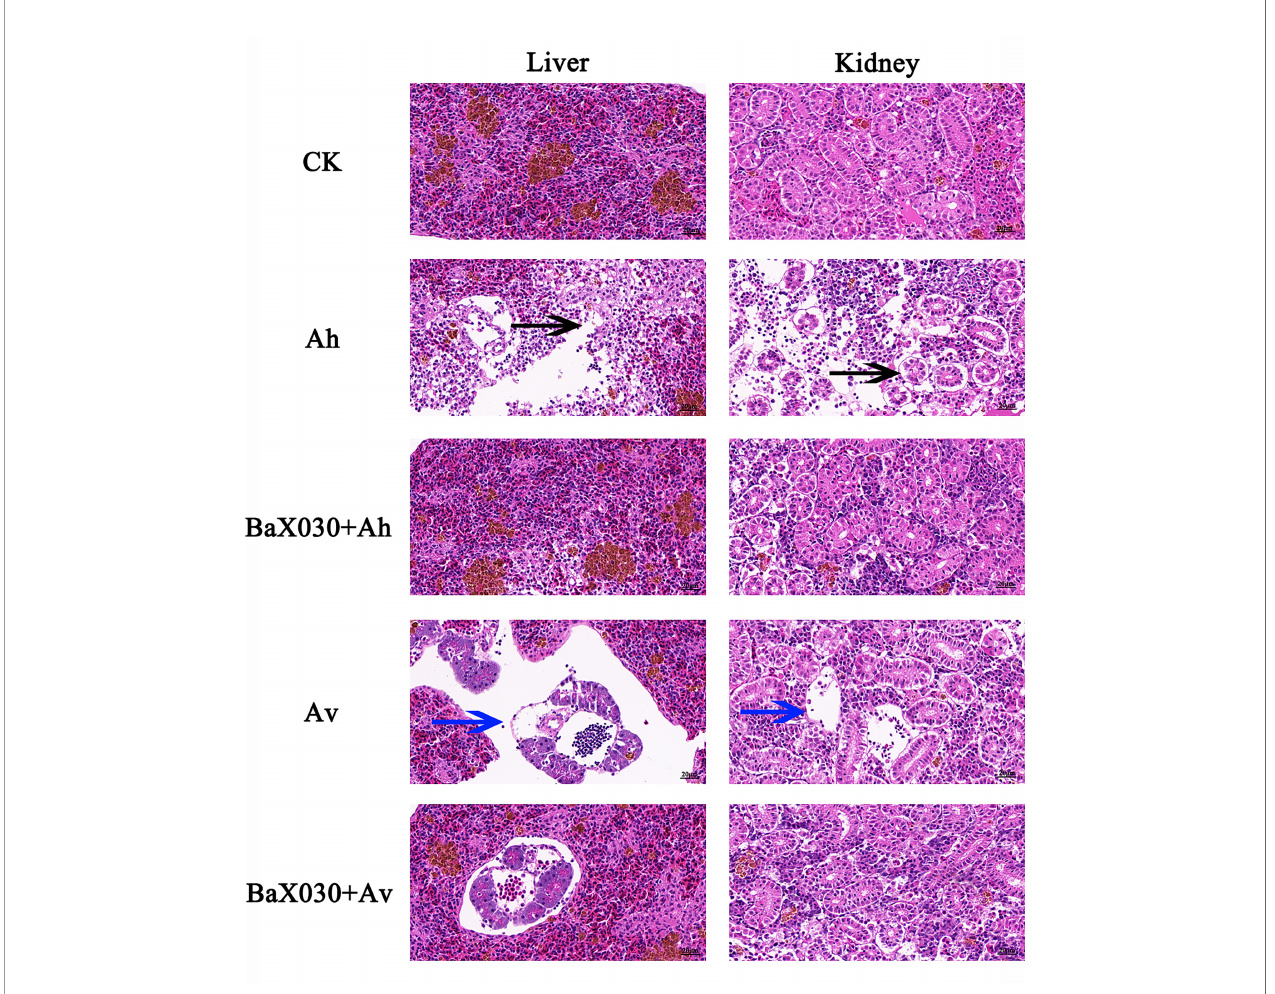
FIGURE 9 | The pathological changes of the liver and kidney in grass carp were observed by H&E staining (400×). The black arrow indicated the hepatocytes were exfoliated by apoptosis, the blue arrow indicated the nephrocyte were exfoliated to form large